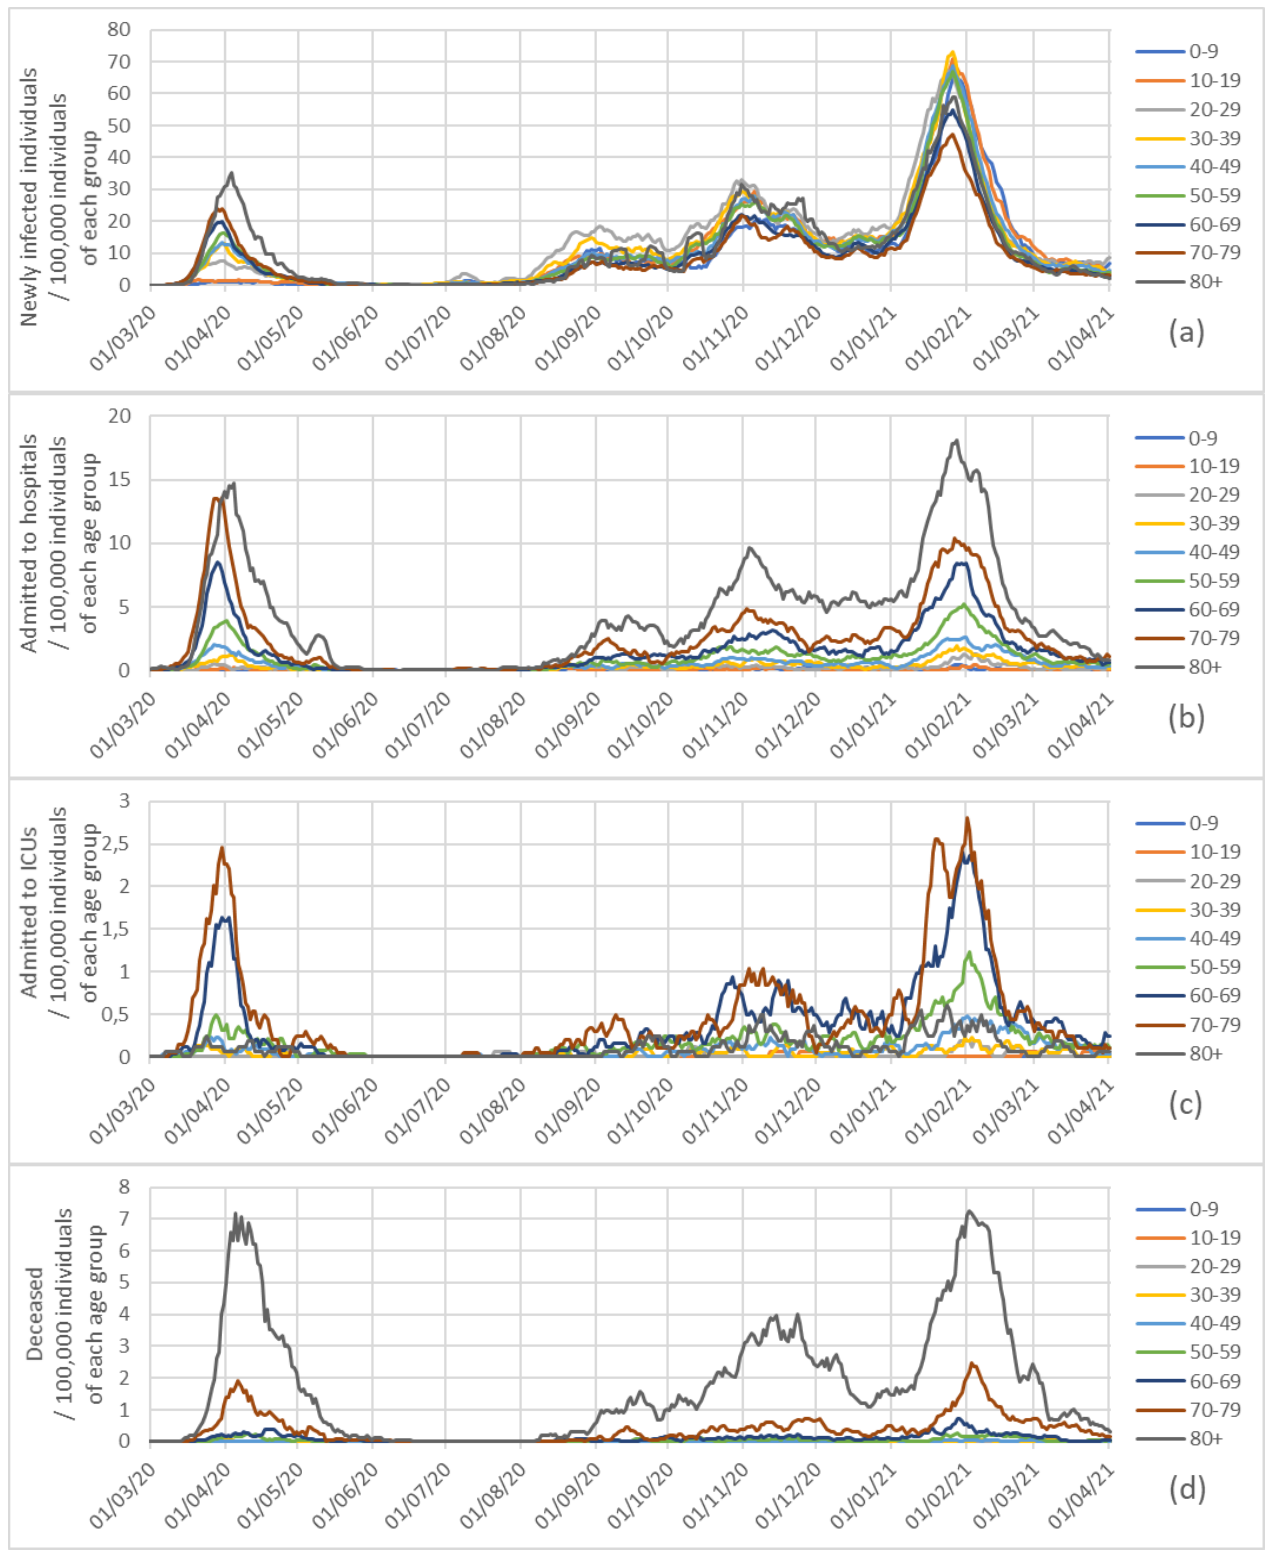
Figure 4. Newly infected ( a ), admissions to hospitals ( b ), admissions to intensive care units ( c ) and deceased ( d ) in Galicia for every 100,000 individuals of each group since the beginning of the pandemic, by considering age groups and means of the seven previous days.